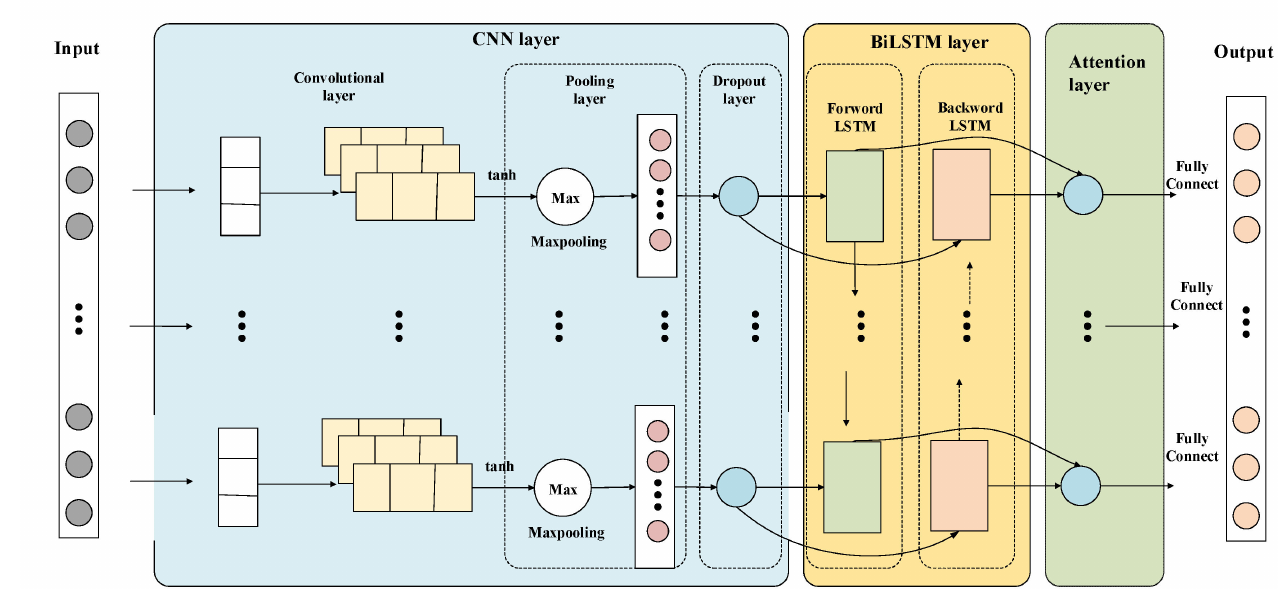
Figure 4. Structure diagram of the CNN-BiLSTM hybrid network